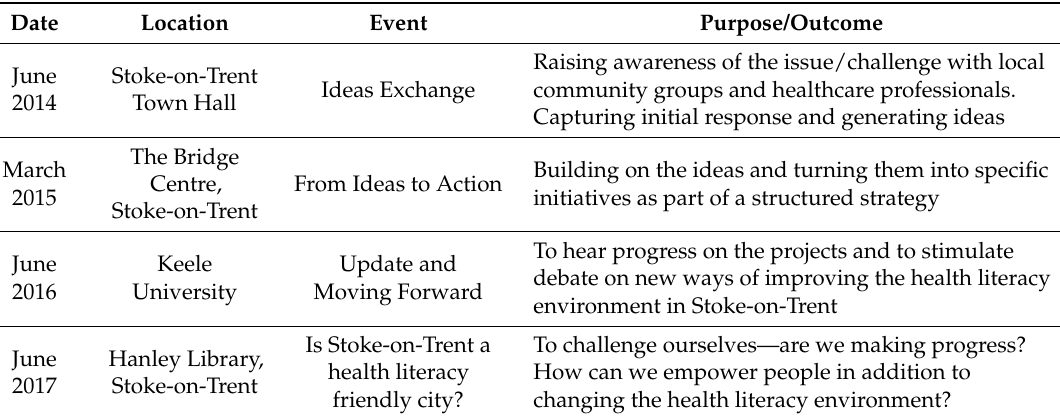
Table 1. Summary of key health literacy activities in